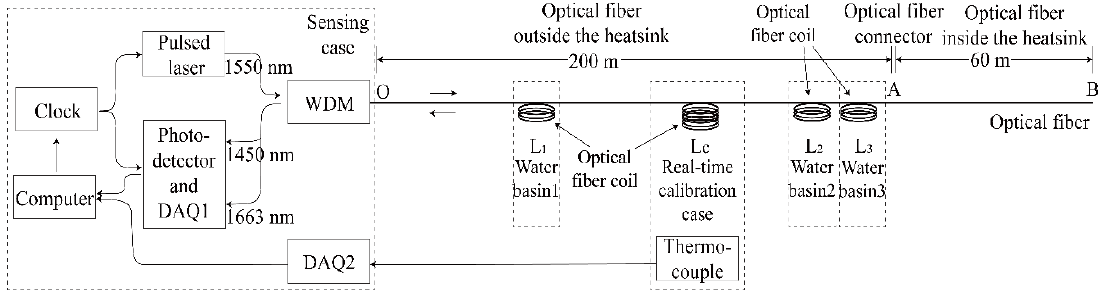
Figure 2. The Raman distributed temperature sensing system.